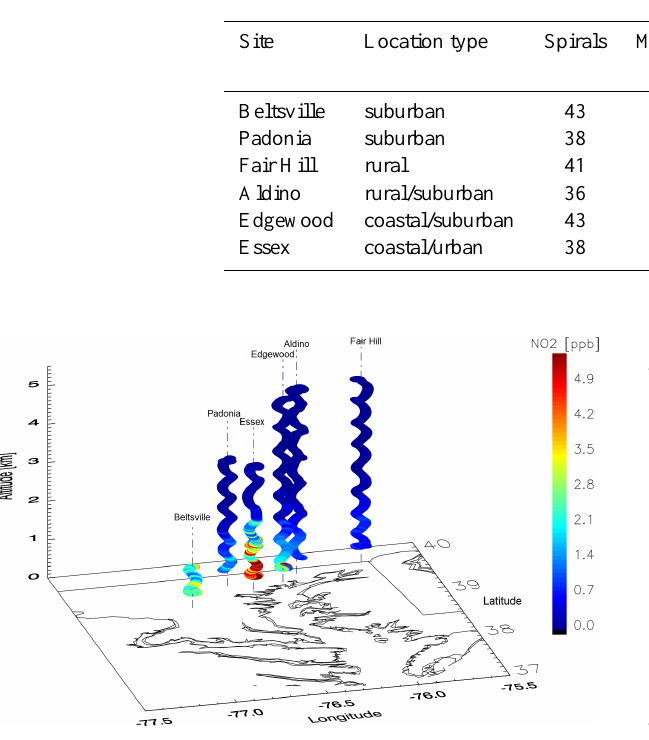
Table 1. Aircraft flight parameters.